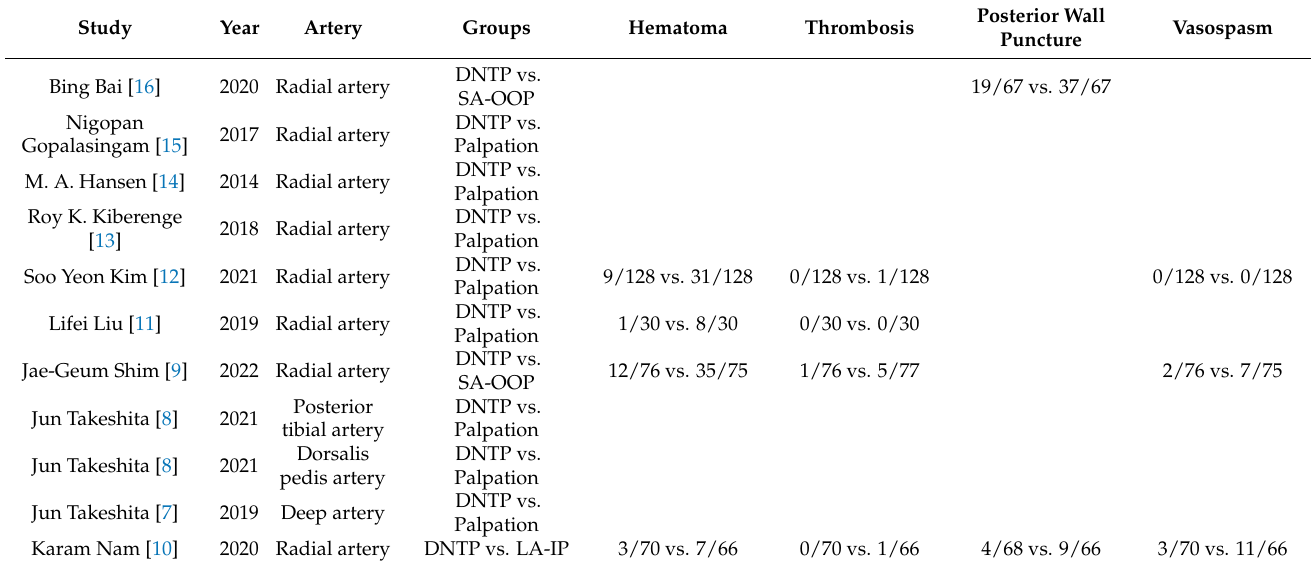
Table 5. Detailed information of complications reported in each